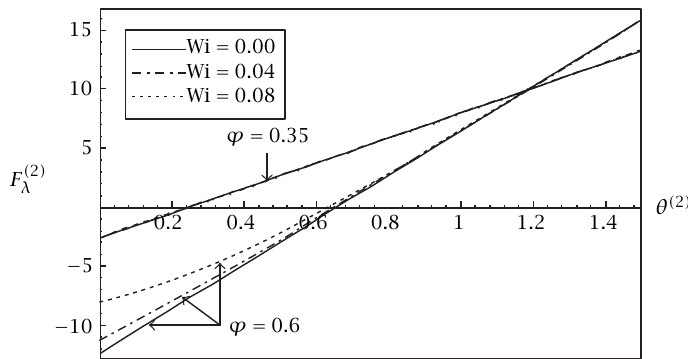
Figure 6.5 . The friction force versus flow rate at Re = 0 . 1, δ = 0 . 156, and ϕ = 0 . 35 , 0 . 6.